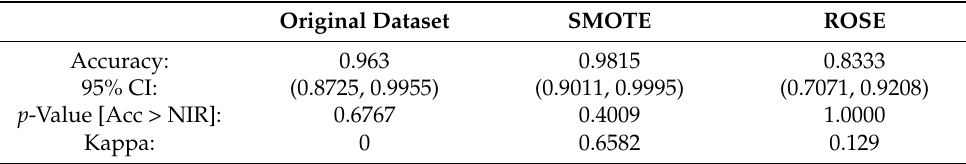
Table 1. Results of the Random Forest method on the Model A dataset.